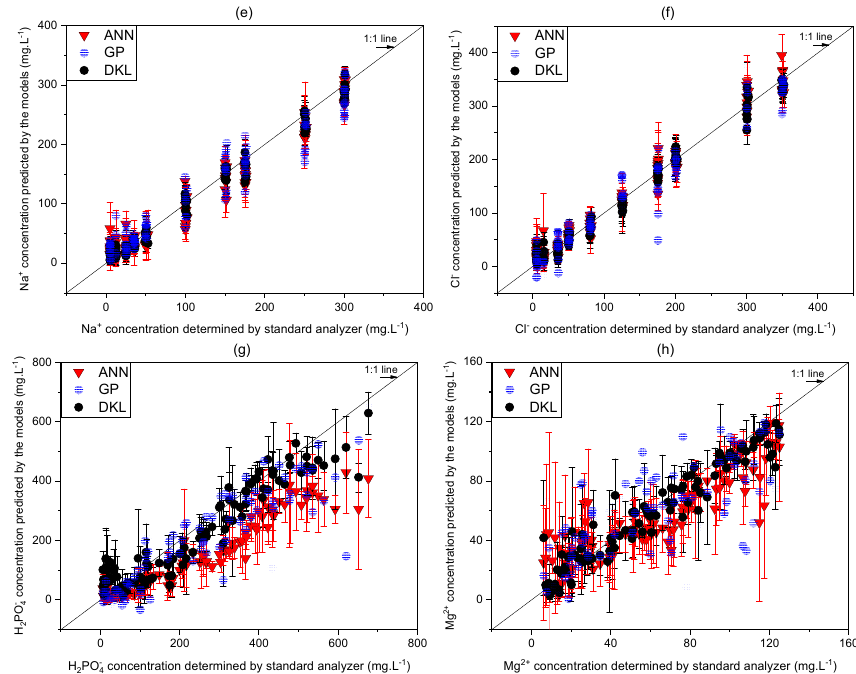
Figure 5. Relationships between predicted ion concentrations of the models and standard analyzers. ( a ) 𝑁𝑂 (cid:2871)(cid:2879) , ( b ) 𝑁𝐻 (cid:2872)(cid:2878) , ( c ) 𝐾 (cid:2878) , ( d ) 𝐶𝑎 (cid:2870)(cid:2878) , ( e ) 𝑁𝑎 (cid:2878) , ( f ) 𝐶𝑙 (cid:2879) , ( g ) 𝐻 (cid:2870) 𝑃𝑂 (cid:2872)(cid:2879) , and ( h ) 𝑀𝑔 (cid:2870)(cid:2878) . Error bars indicate standard deviations of three replicates.